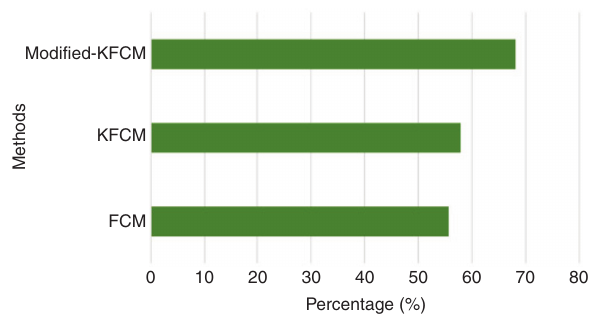
Figure 9: Graphical comparison of the Jaccard coeflcient. Table 2: Accuracy and specificity comparison of the existing and proposed